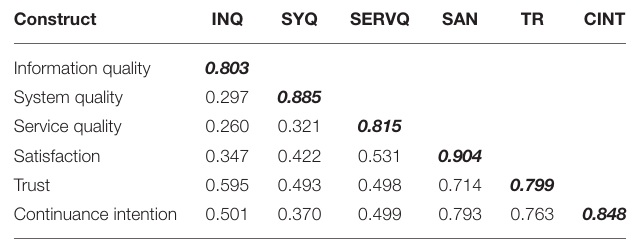
TABLE 4 | Discriminant validity.